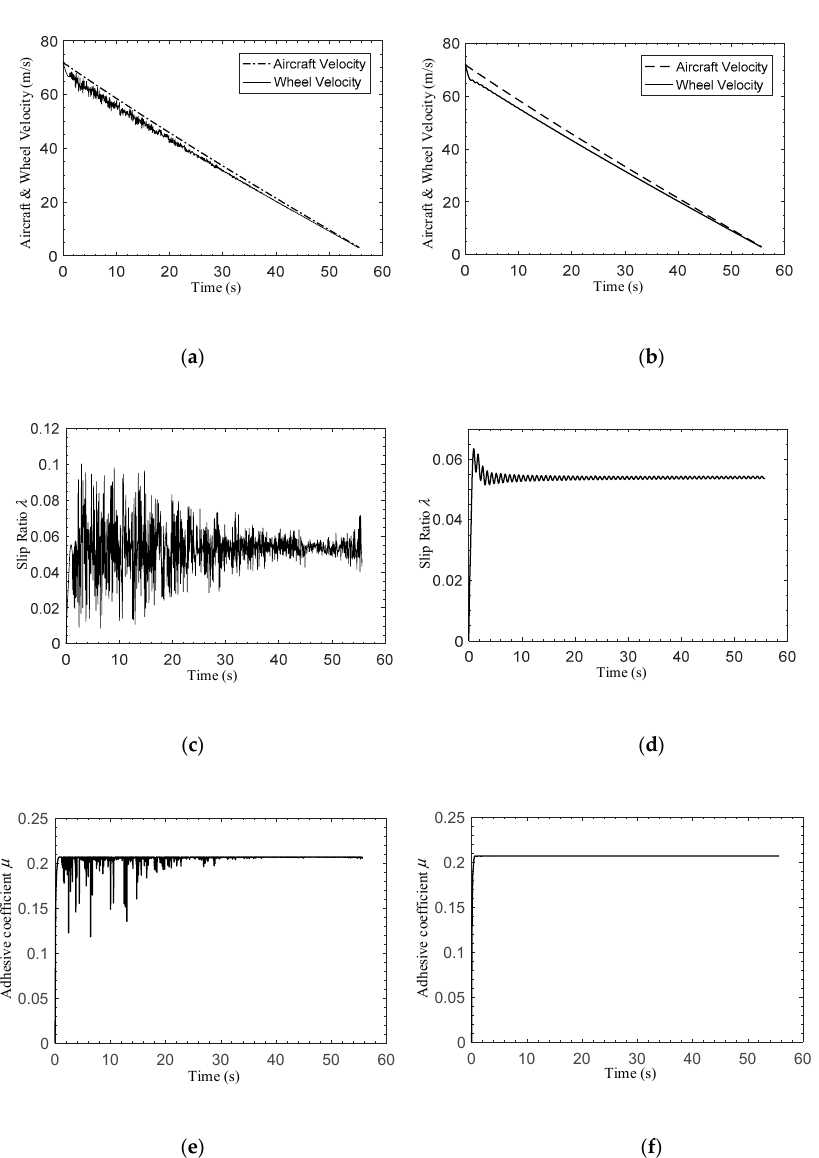
Figure 11. Slip ratio control performance of the ABS controller in icy runway conditions. ( a ) Aircraft velocity and wheel velocity in PID control; ( b ) aircraft velocity and wheel velocity in the proposed control method; ( c ) slip ratio in PID control; ( d ) slip ratio in the proposed control method; ( e ) adhesive coefficient between wheel and runway in PID control; ( f ) adhesive coefficient between wheel and runway in the proposed control method.